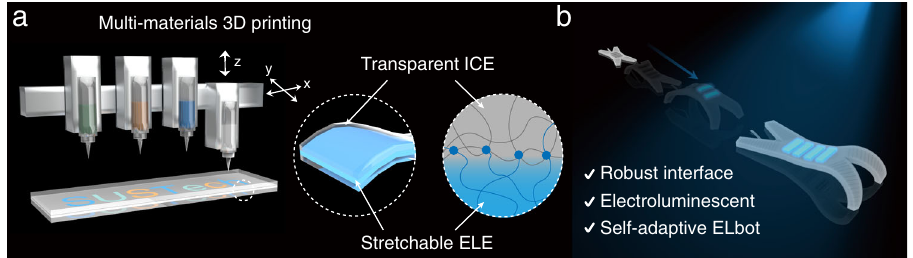
Fig.1|3Dprintingofelectroluminescentdevicesandanintegratedfabrication strategyforself-adaptivesoftrobots.a Schematicillustrationshowingthemulti- material direct ink writing of fl exible EL devices. The electroluminescent devices consist of an electroluminescent elastomer (ELE) layer and an insulating